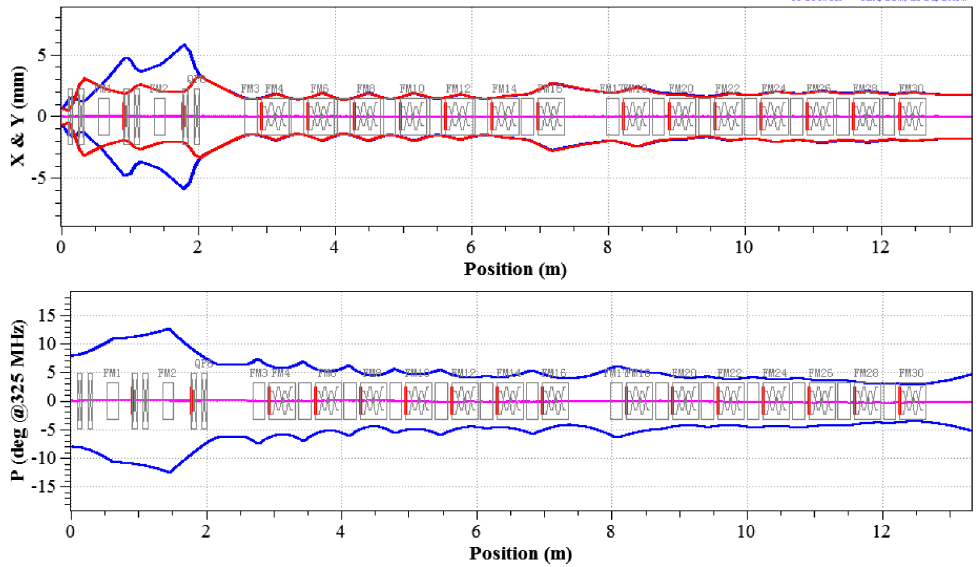
FIG. 22. The envelope evolution of the SC section of Injector I together with MEBTwith 50% input emittance deviation (increasing in all three directions).